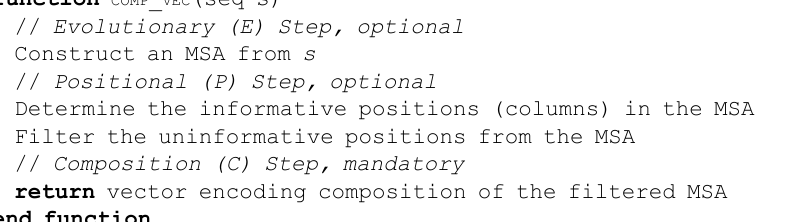
Algorithm 1 . Template for constructing the composition vector .